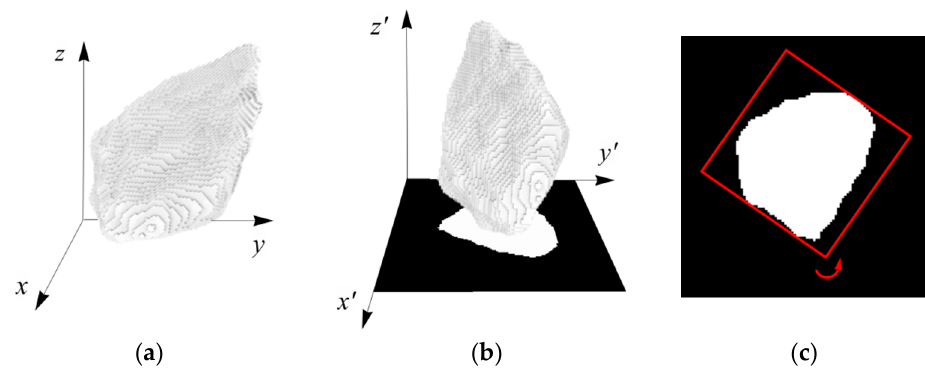
Figure 3. Illustration of 3D digital sieving of an aggregate: ( a ) voxel data in global coordinate; ( b ) perform coordinate conversion and obtain projection; ( c ) solve the minimum bounding square.